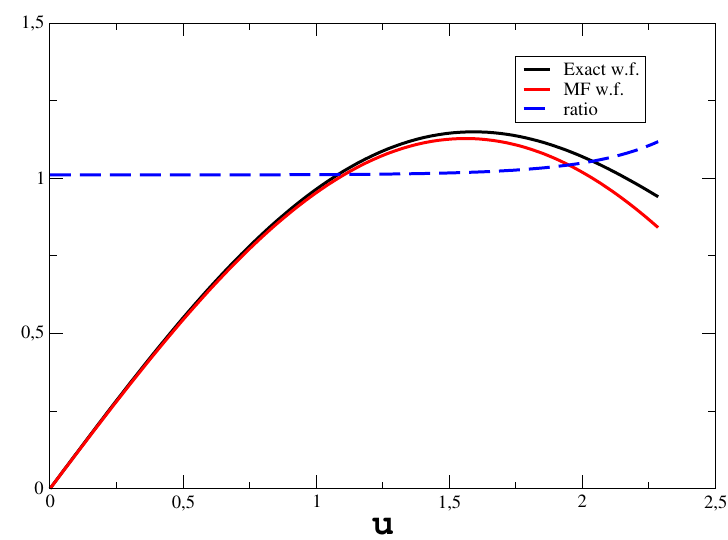
Figure 1 . The numerical solution of the Faddeev equation vs. the Minlos-Faddeev wave function. The parameters are taken as (cid:3) = 10 4 and (cid:20) = 1779 : 3756, corresponding to H ((cid:3)) = 0. We namely plot the functions j p=(cid:20) (cid:9)( p=(cid:20) ) j , j p=(cid:20) (cid:9) 0 ( p=(cid:20) ) j and A ( p=(cid:20) ) from eq. (3.18) vs. the dimensionless variable u , which is de(cid:12)ned in eq. (3.12). The ratio of two functions, A , is very (cid:13)at and approaches the value A = 1 : 0105863 at the